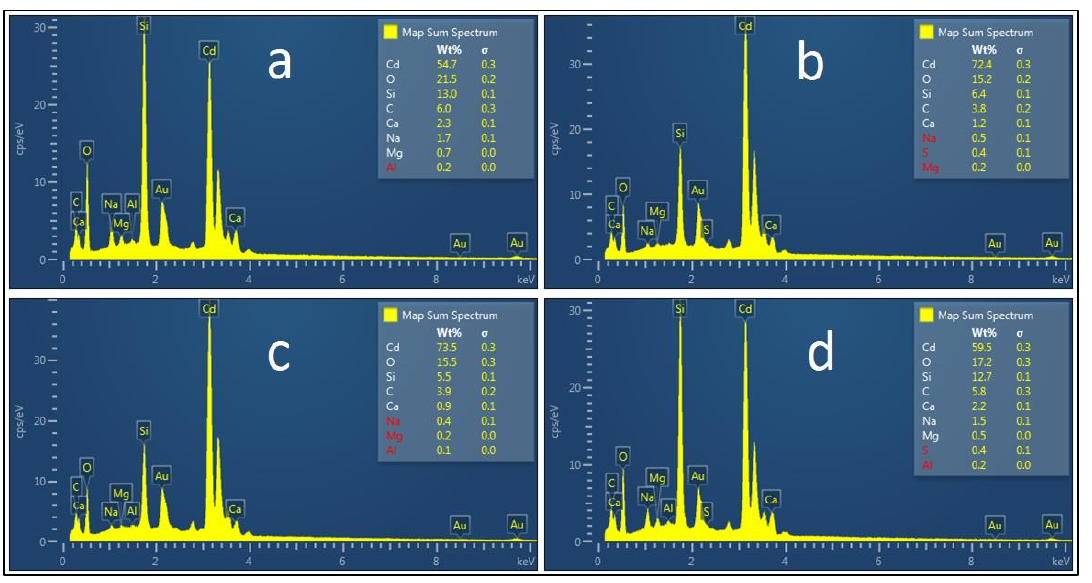
Figure 8. EDX of as-deposited and annealed thin films at different annealing times. ( a ) As-deposited, ( b ) 20 min, ( c ) 40 min, and ( d ) 60 min. Table 4. Compositional analysis of CdO thin films at different annealing times.